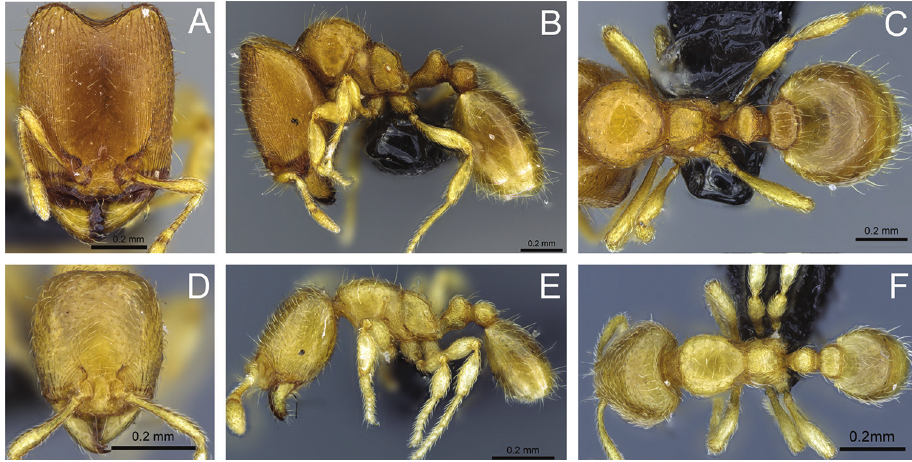
Figure 47. Carebara lova –holotype. Major worker, CASENT0468707: A head in full-face view B body in profile view C body in dorsal view. Minor worker, CASENT0468562: D head in full-face view E body in profile view F body in dorsal